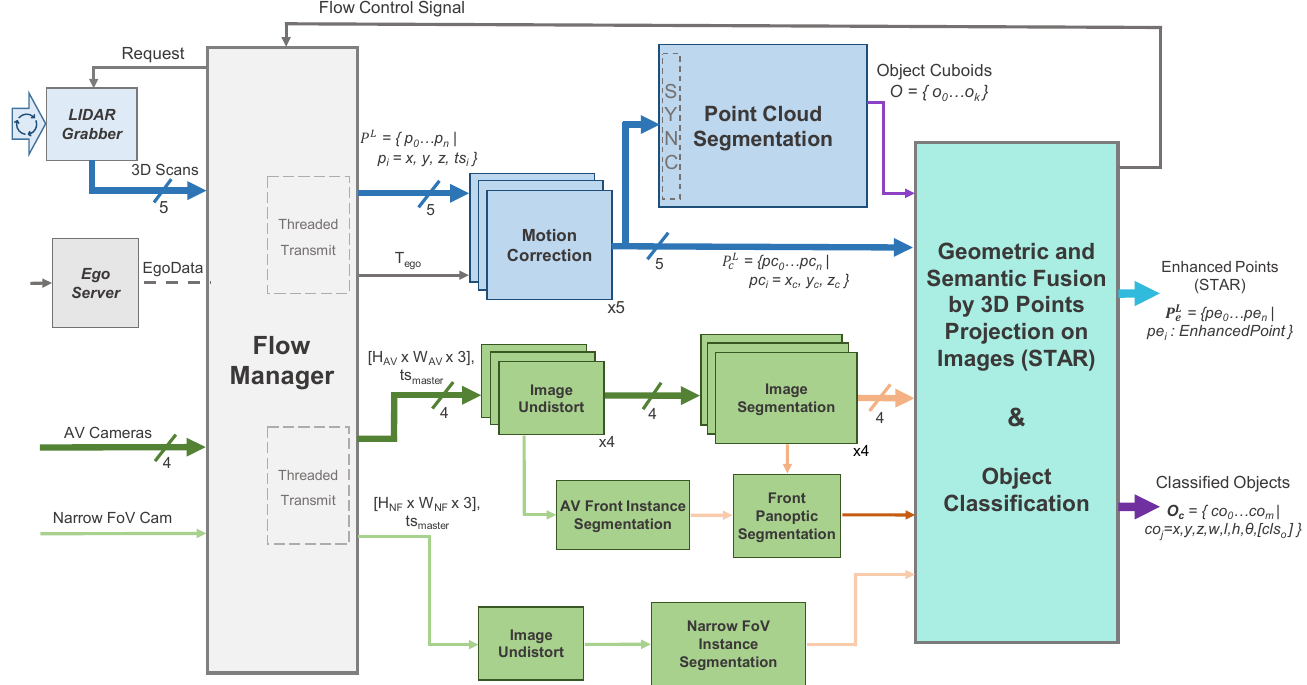
Figure 4. Data flow architecture of the proposed enhanced perception system: 3D geometric informa- tion (blue, top part) is processed in parallel with 2D camera images (green, bottom part) before the final merger of the two.